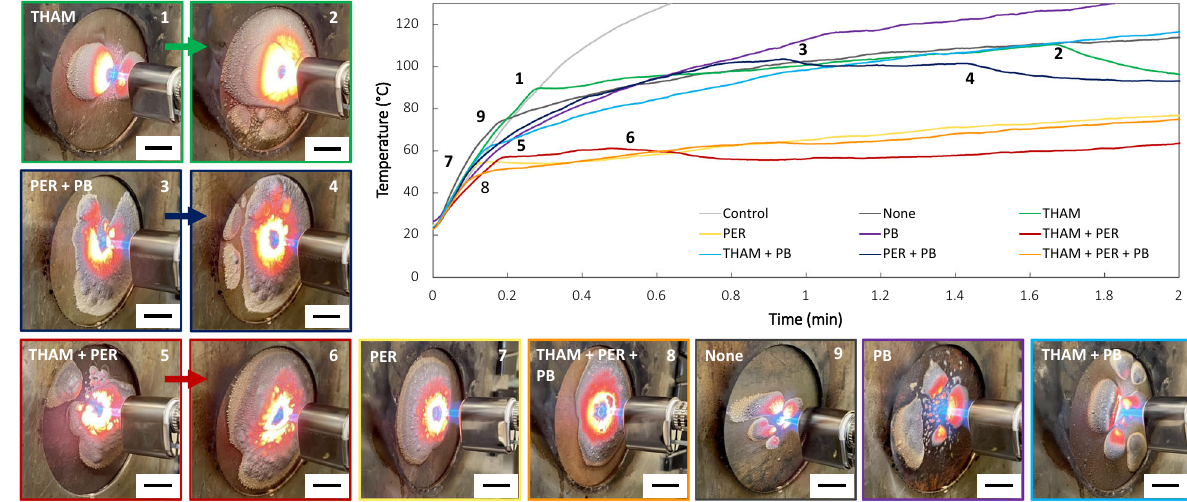
Fig. 5 Formation of Insulating Bubbles. Formation of macroscale bubbles and the backside recorded temperature of the steel for each of the fi lm types: No additive (gray), THAM (green), PER (yellow), PB (purple), THAM + PER (red), THAM + PB (blue), PER + PB (navy), and THAM + PER + PB (orange). Numbered points on the graph correspond to the surrounding fi lm images. Scale bars are 1